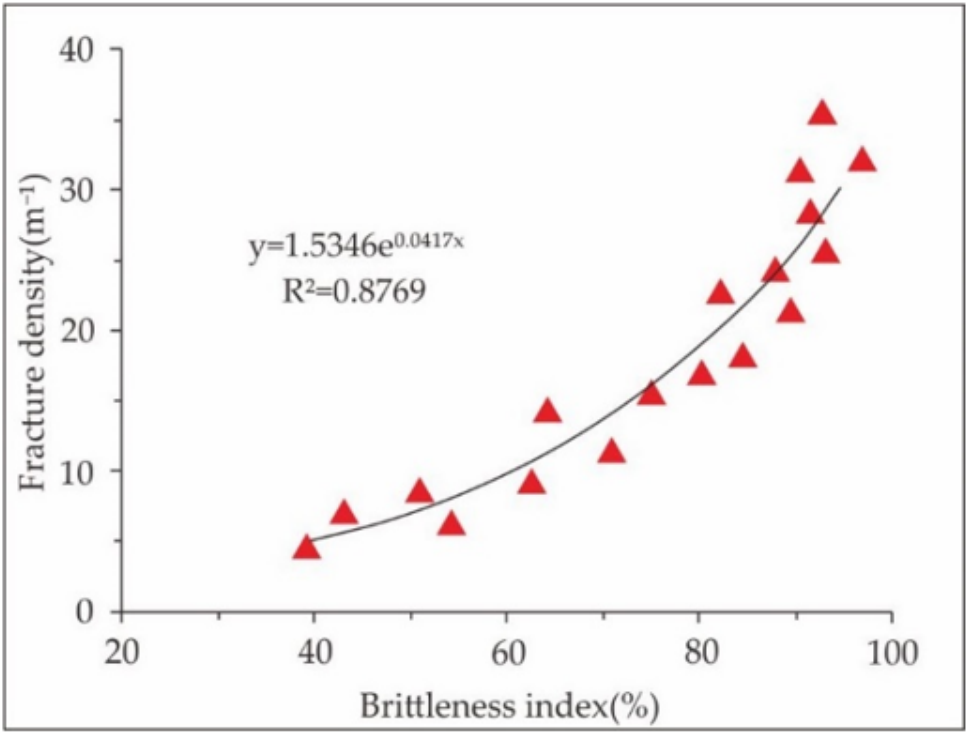
Figure 8. Relationship between brittleness index and fracture density in Qingshankou shale. Samples were collected from outcrops.